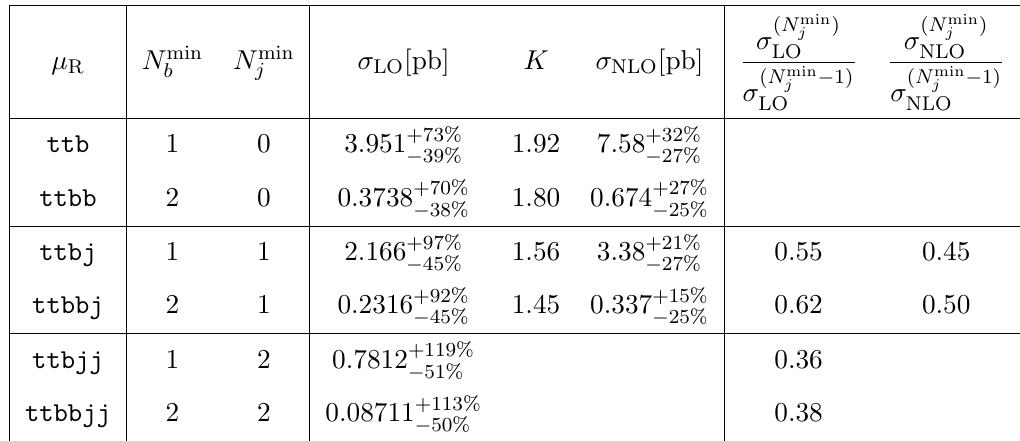
Table 3. Cross sections at LO and NLO for pp integrated regions with di(cid:11)erent numbers of b -jets, N min The acceptance cuts (3.11) are applied. Predictions for N min with (cid:22) R = (cid:22) and (cid:22) F = H T = 2, while N min t (cid:22) tb (cid:22) b